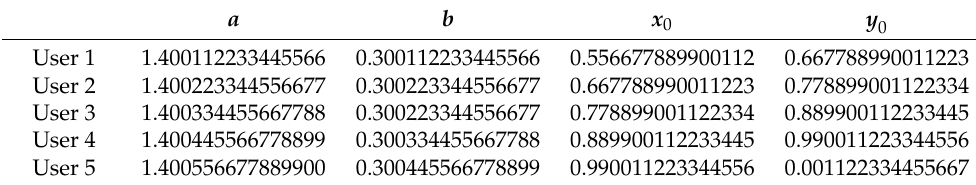
Table 3. Secret key definition for encryption process of the five users.